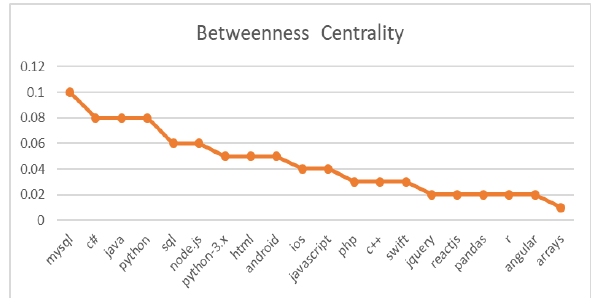
Figure 17. Betweenness Centrality